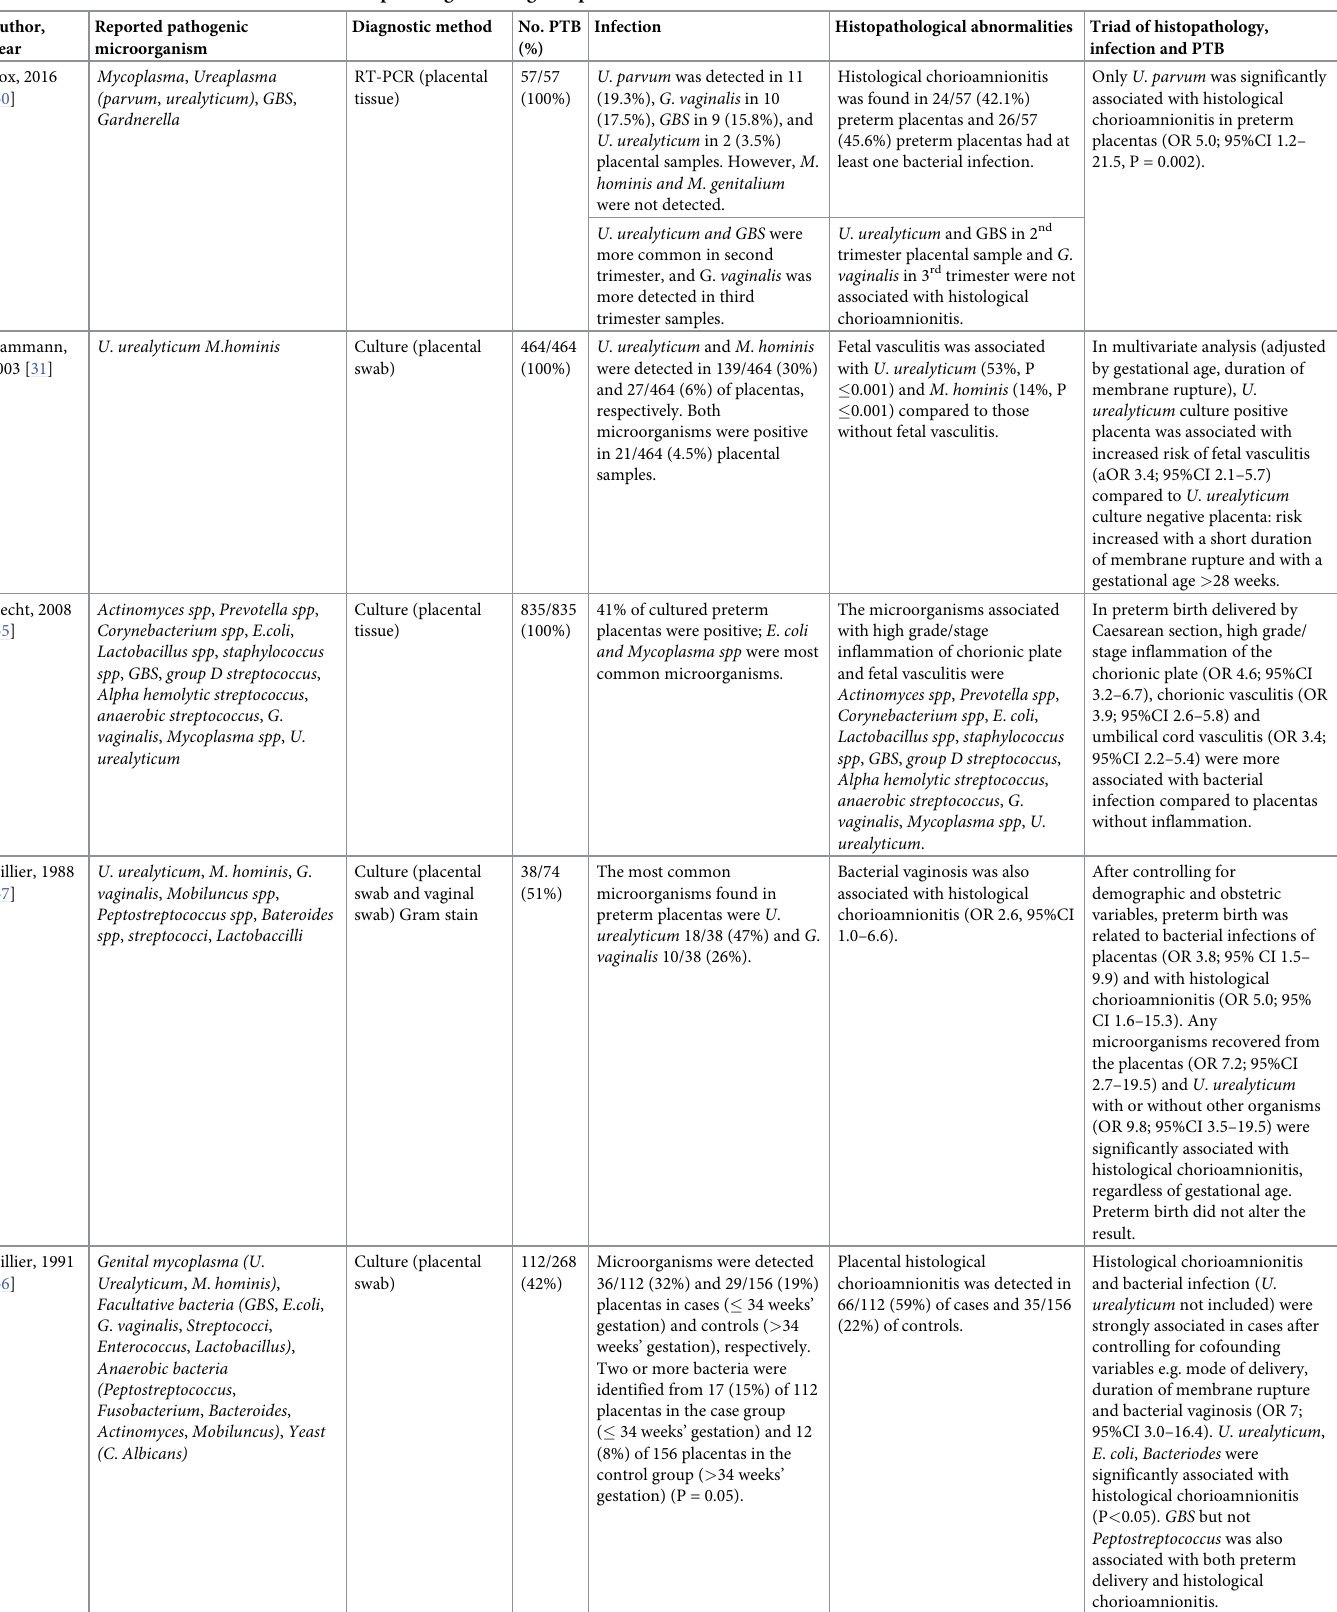
Table 2. Identified bacterial infection and histopathological changes in preterm